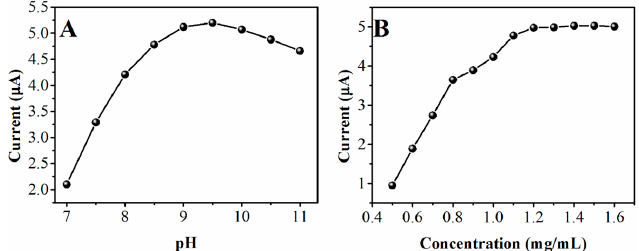
Figure 4. Effect of peak current on ( A ) the pH of the detection solution and ( B ) the concentration of α -naphthyl phosphate ( α -NP) at 100 ng/mL NSE.